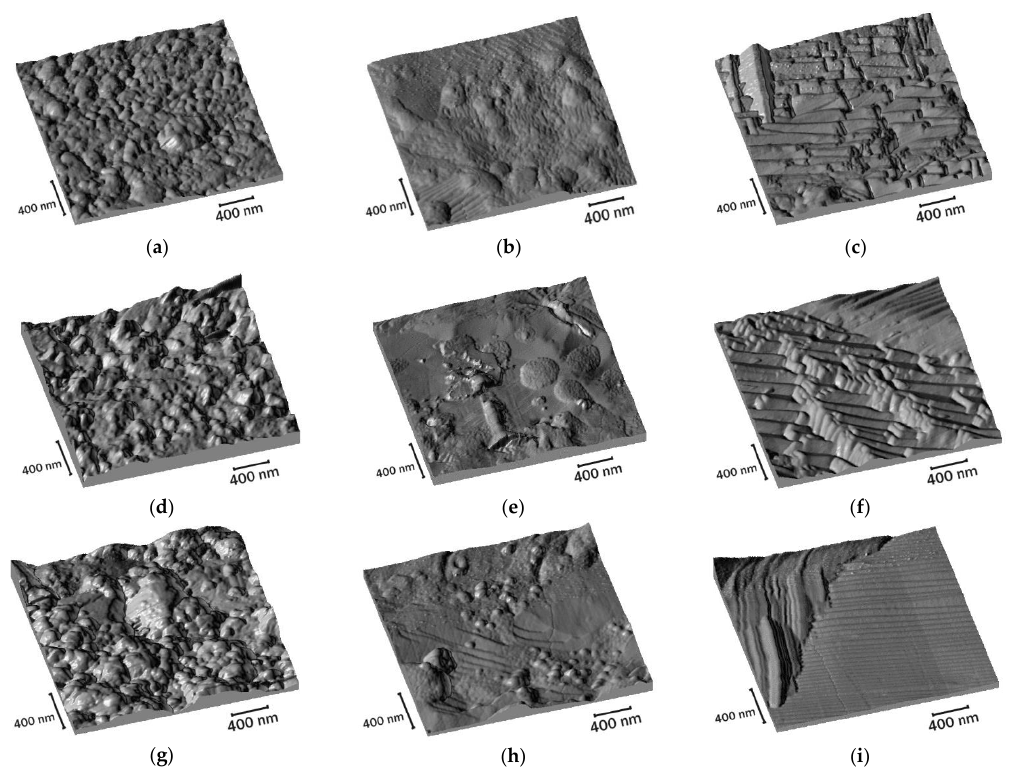
Figure 5. Microstructure of Fe-3%Si-0.5%Cu layer surfaces with MgO coating after annealing at dif- ferent temperatures: ( a – c ) 700 °C; ( d – f ) 800 °C; ( g – i ) 1000 °C; ( a , d , g ) the surface; ( b , e , h ) the surface depth about of 1 µm; ( c , f , i ) the surface depth about of 5 µm. The results of GDOES and the ThermoCalc calculations (Figures 3 and 4) allow us to state that the phase composition of the material changes from layer to layer with an in- creasing temperature: new phases are formed, while some phases disappear; the compo- sitions of the phases change, and their proportions are different depending on the depth.